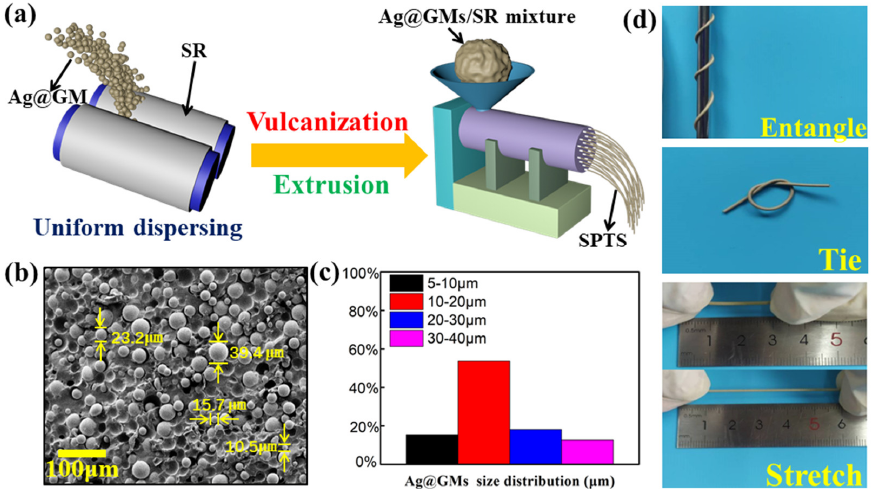
Figure 1. ( a ) The preparation process of the stretchable piezoresistive thread sensor (SPTS). ( b ) The SEM images of the SPTS. ( c ) The size distribution diagram of the Ag@GMs. ( d ) The various states of the SPTS were demonstrated including entangled, tied, and stretched.